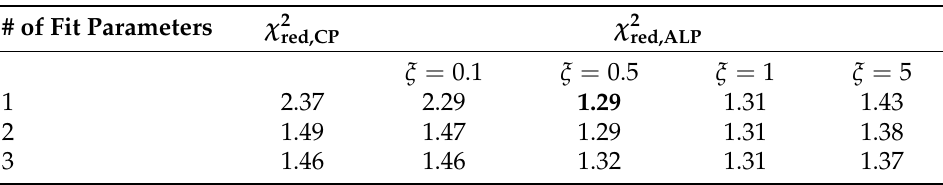
within the ALP scenario, for red,ALP . red,ALP